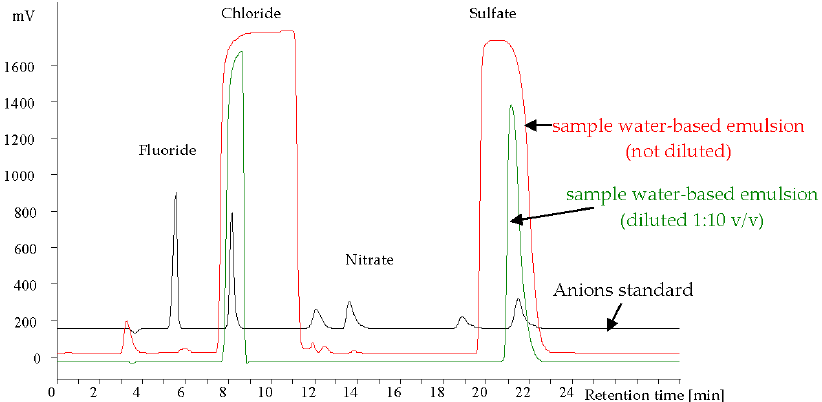
Figure 3. Chromatograms of anions standard + sample of water-based emulsion (not diluted and diluted 1:10 v / v ). Separation condtions: column: Metrohm Metrosep A Supp 3 (250 × 4.6 mm); eluent: 1.7 mM Na 2 CO 3 + 1.6 mM NaHCO 3 ; eluent flow rate: 0.85 mL/min injection volume: 20 µ L; detection: suppressed conductivity detection.